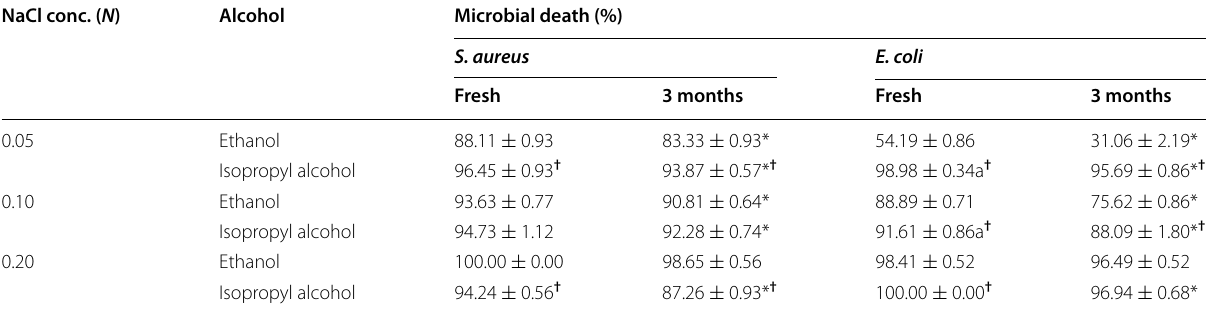
Values represent means SD. Values with * indicate a significant difference ( P < 0.05) from fresh sample for the same alcohol/electrolyte/organism. Values † indicate ± significant difference ( P < 0.05) from ethanol for the same electrolyte/organism/test time. N